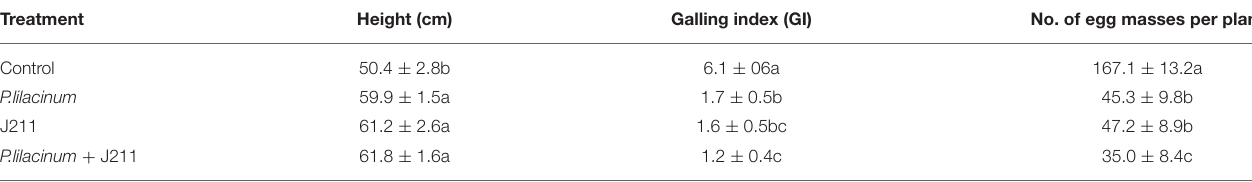
TABLE 2 | Effects of J211 on the growth of plants and the formation of root-knots in tobacco roots caused by M. incognita in the pot trial.